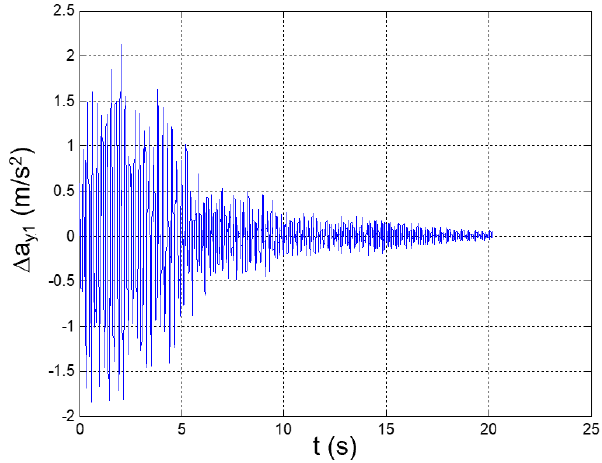
Figure 10. Seismic response, interstory acceleration at the 1st floor ( Δ 𝑎 y1 = 𝑎 y1 ).